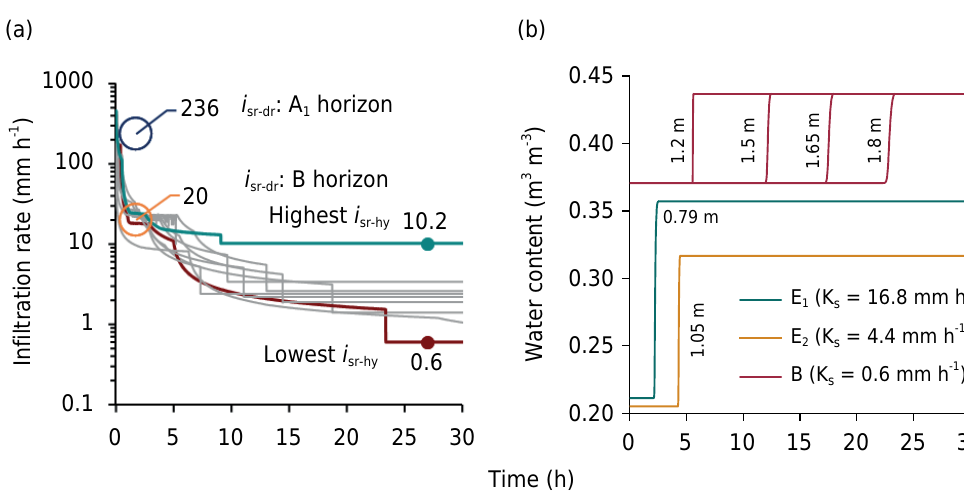
Figure 3. Infiltration rate simulated by Hydrus-1D for all plots and the average of i sr-dr measured with double-ring infiltrometer at top of A 1 and B horizons (a); the upper and lower colored lines correspond to the soil profile less and more restrictive to water infiltration. Water content simulated by Hydrus-1D at different depths along time